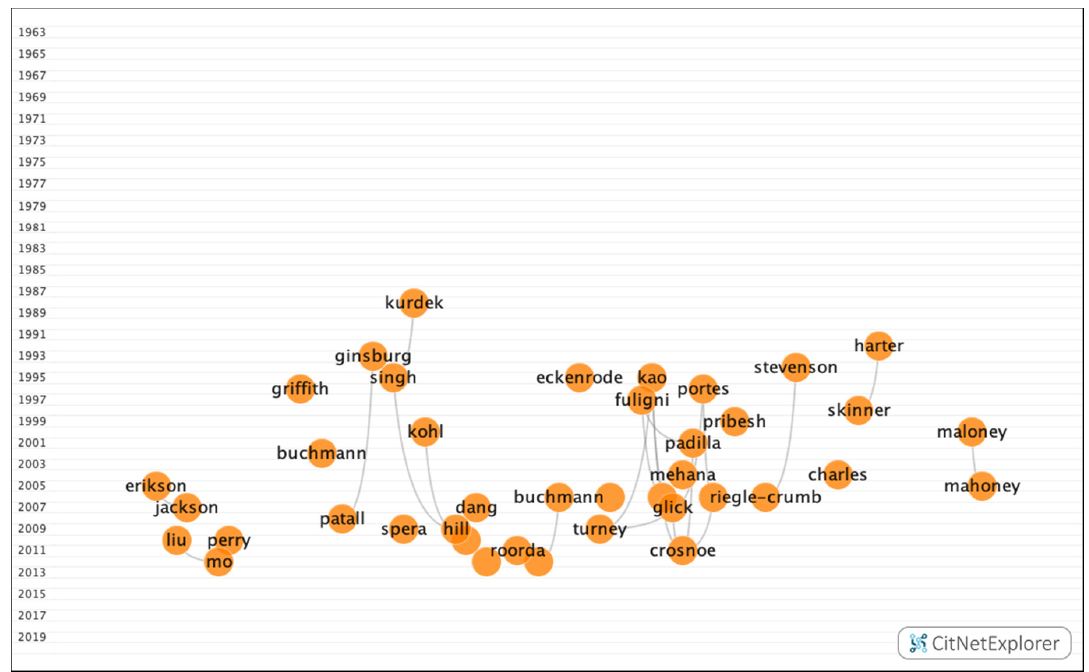
Figure 10. Group 4 citation network.